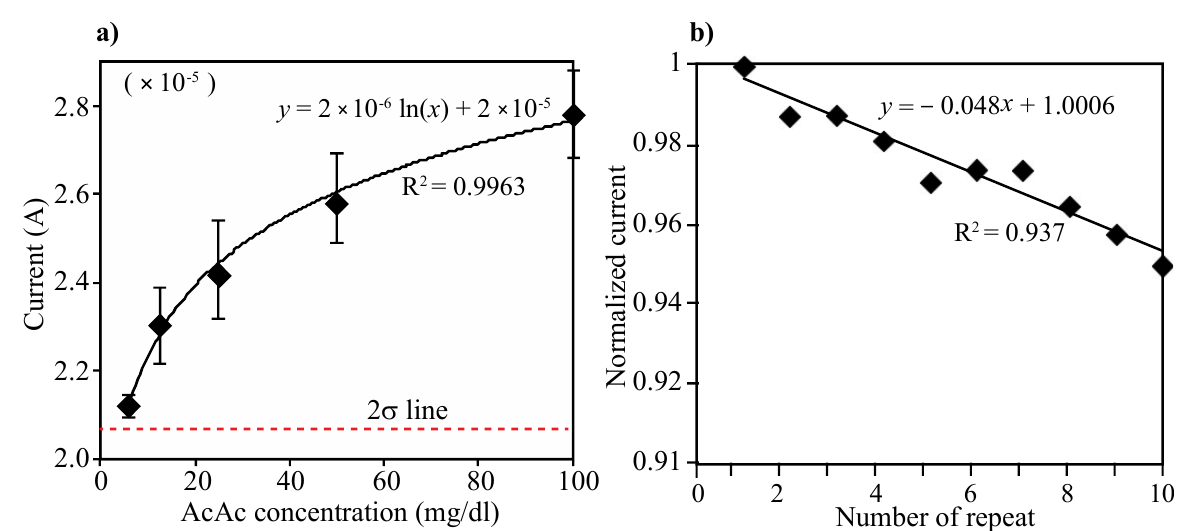
Figure 4. ( a ) Changes of current level according to the concentration of AcAc. Five different concentrations of AcAc (6.25, 12.5, 25, 50 and 100 mg/dL) and PBS (0 mg/dL) were prepared and performed CV measurement. Then, 80 µ L of each